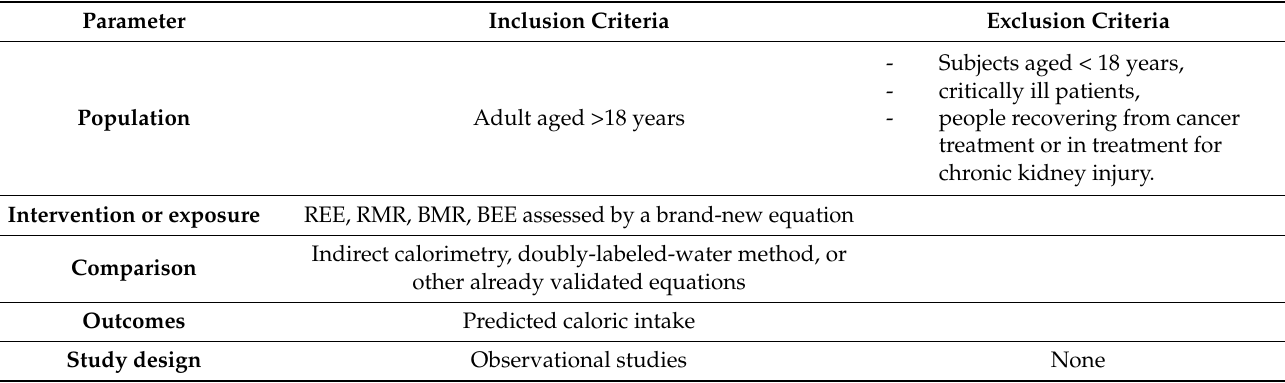
Table 1. Summary of Population, Intervention or exposure, Comparison, Outcomes, and Study design